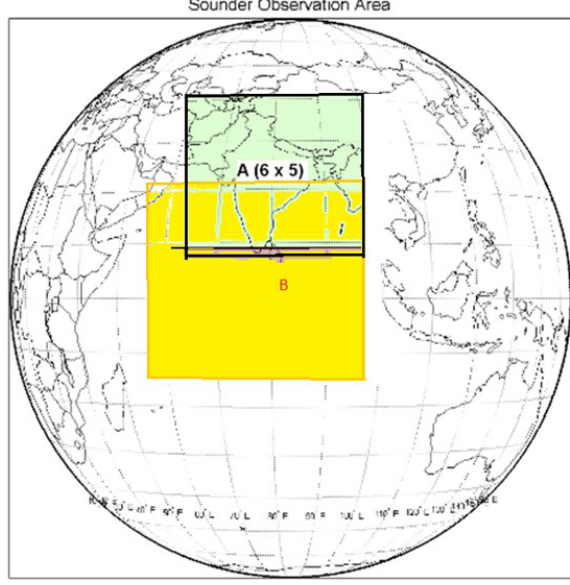
Figure 1. Scan strategy and area of coverage of INSAT-3DR sounder payload.